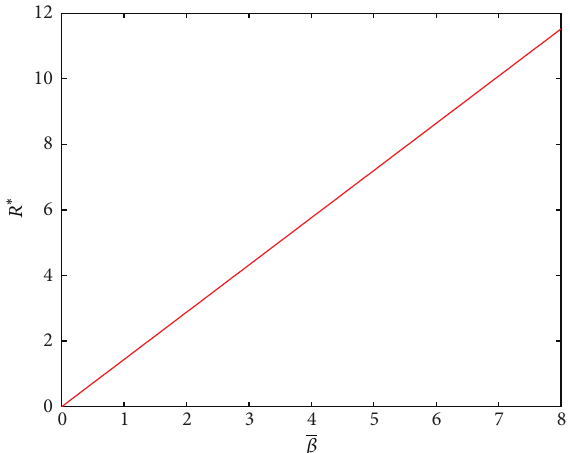
Figure 3: The graph of the upper threshold value 𝑅 ∗ versus 𝛽 .